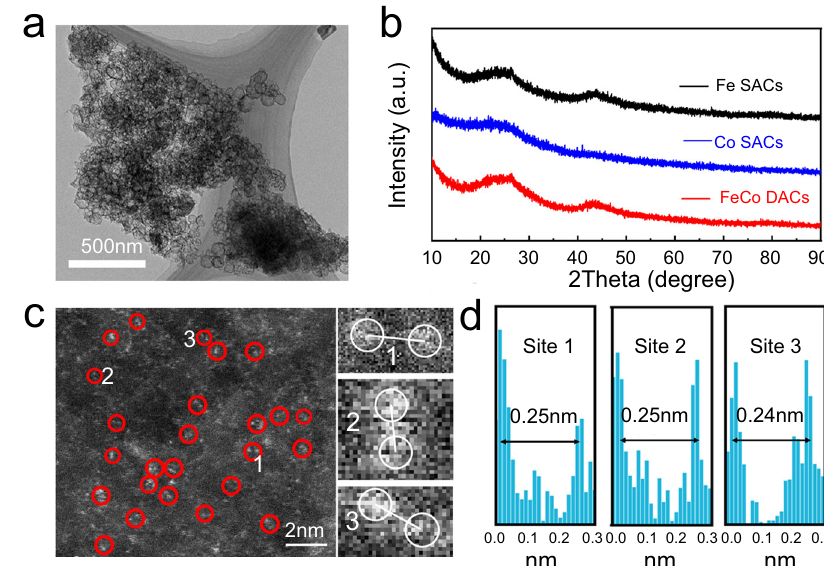
Fig. 2 | TEM and XRD characterization of Fe-Co DACs. a TEM image of Fe-Co DACs. b XRD patterns of Fe-CoDACs and Fe(Co) SACs. c Aberration-corrected HAADF-STEM image of Fe-Co DACs and some Fe-Co diatomic sites are highlighted